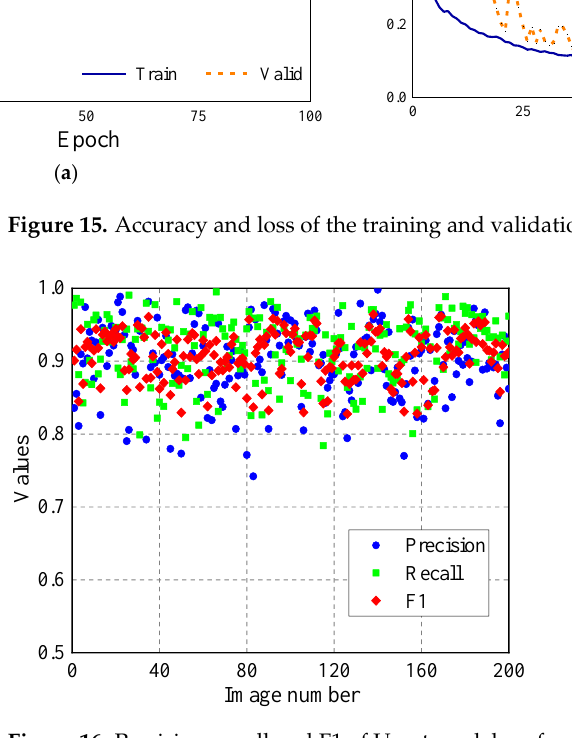
Figure 16. Precision, recall and F1 of U-net model performance on test dataset. Table 2. Performance of U-net model for concrete crack segmentation.